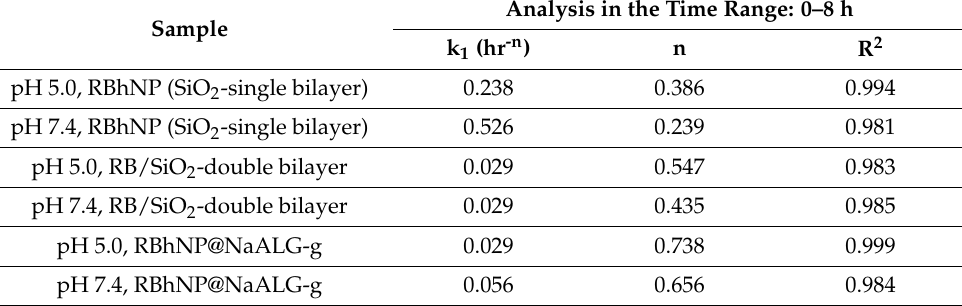
Table 1. Fitting parameters obtained by applying the Korsmeyer–Peppas model (Equation (5)) to the RB release data at 37 ◦